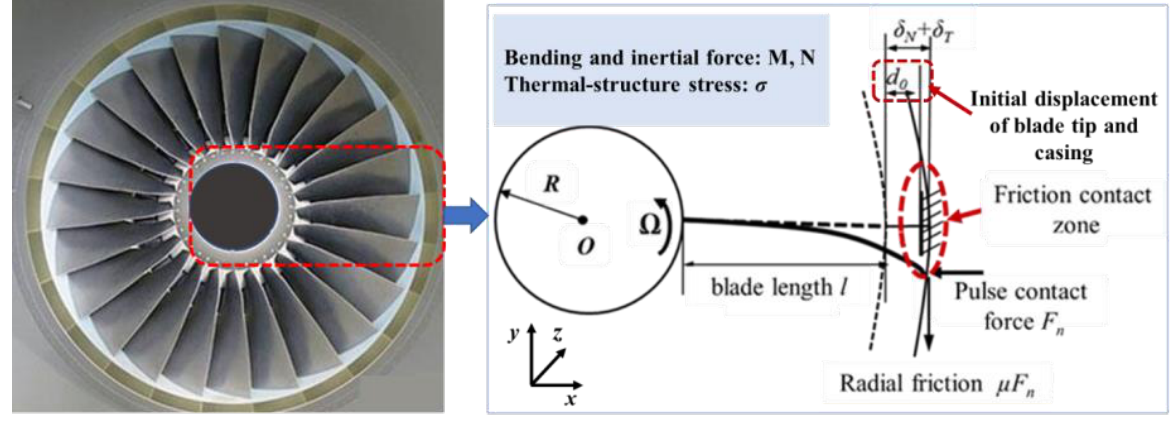
Figure 2. The thermal deformation of a thin-walled blade [25]. Based on von Karman’s large deflection theory and plate shell theory [22], in-plane strain and curvature vectors are displayed as: